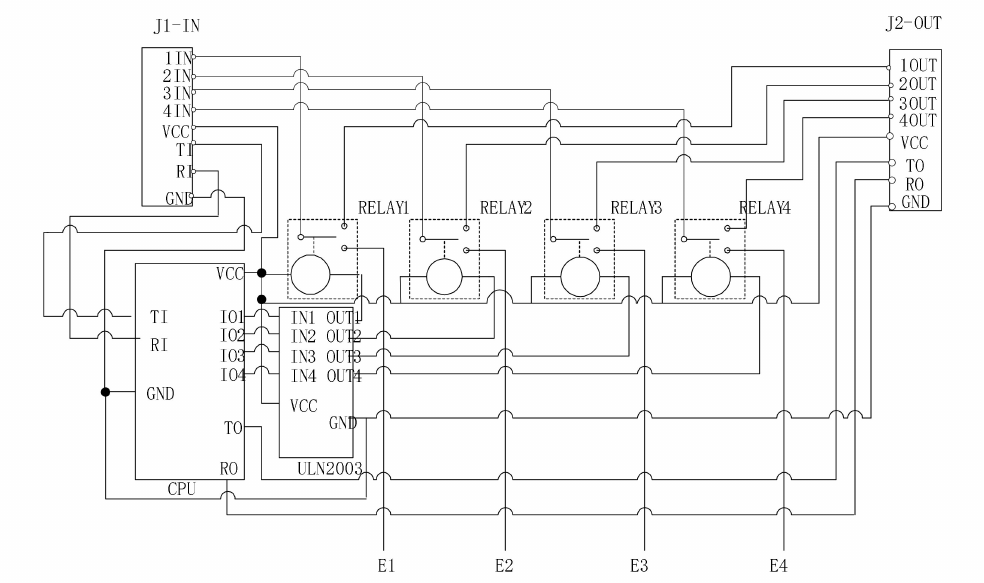
Figure 6. Distributed cell structure for four electrodes in one cell